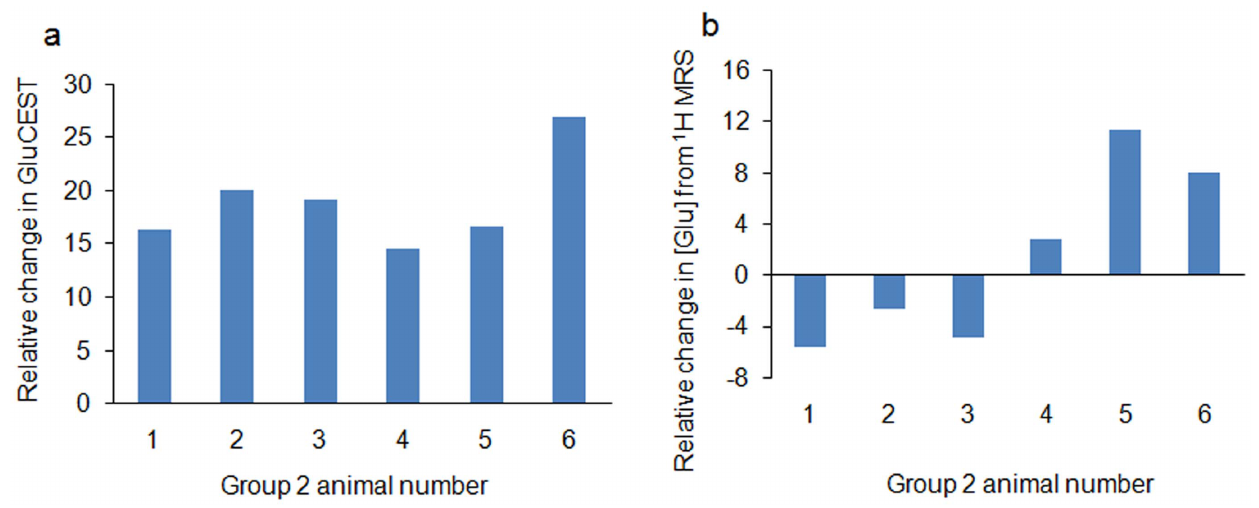
Figure 3. Relative change in GluCEST and Glx concentration from 1 HMRS. Bar graphs show relative change in GluCEST contrast (a) and Glx concentration from 1 HMRS (b) 24 hours post Modafinil administration for the group 2 rats (n=6). While the change in GluCEST was positive in all rats, the change in Glx concentration was inconsistent.